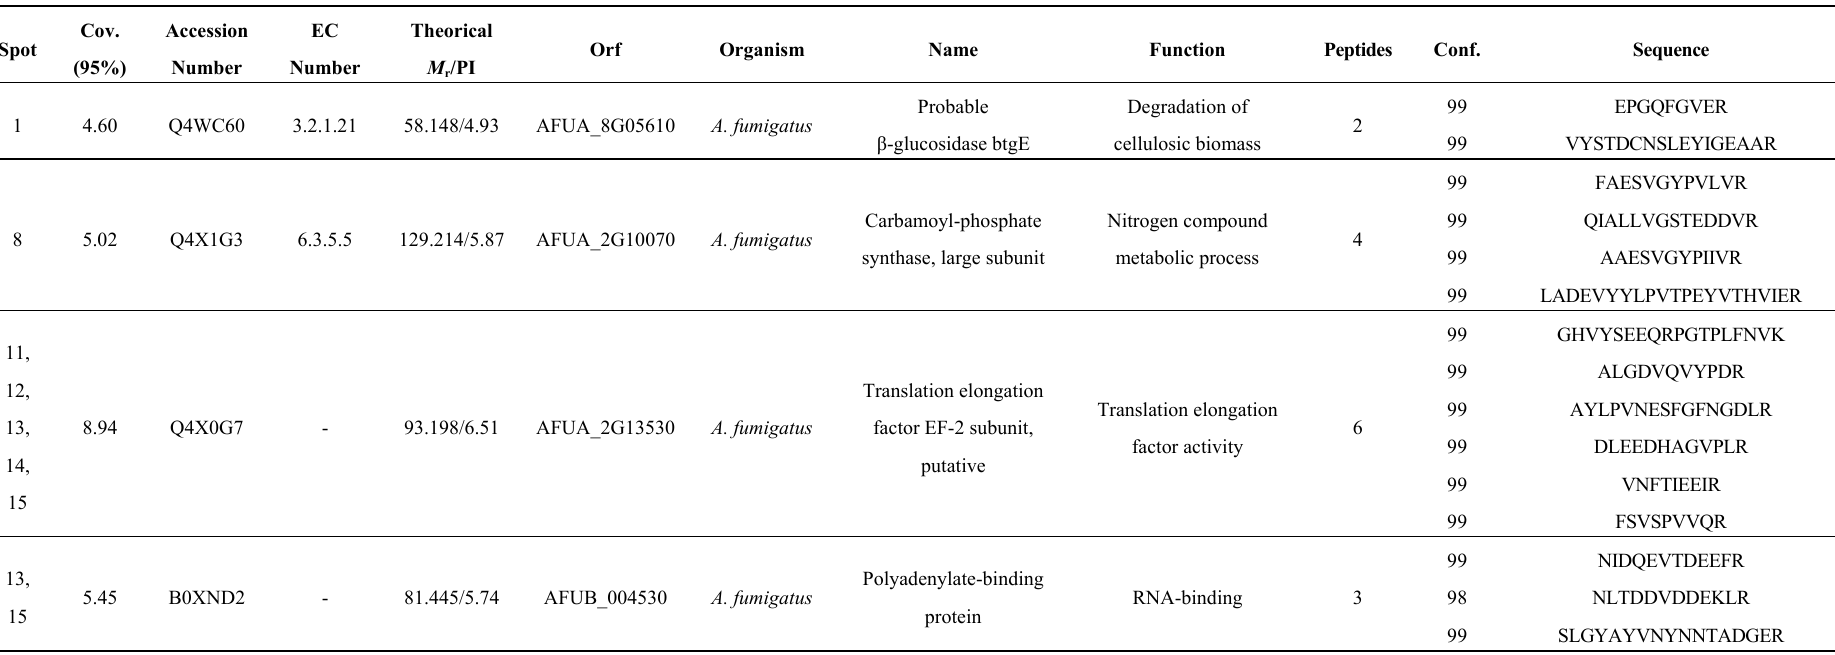
Table 1. All antigenic proteins identified via mass spectrometry (MS/MS) in the cell surface extracts of A. fumigatus . Spot